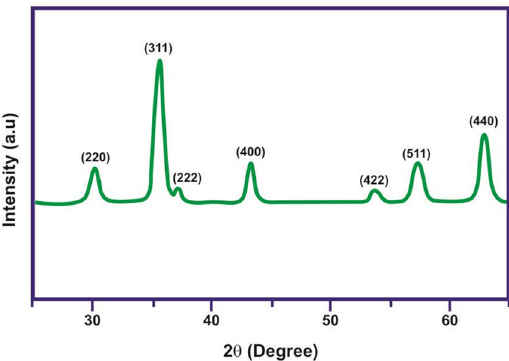
O nanoparticles. 2 4